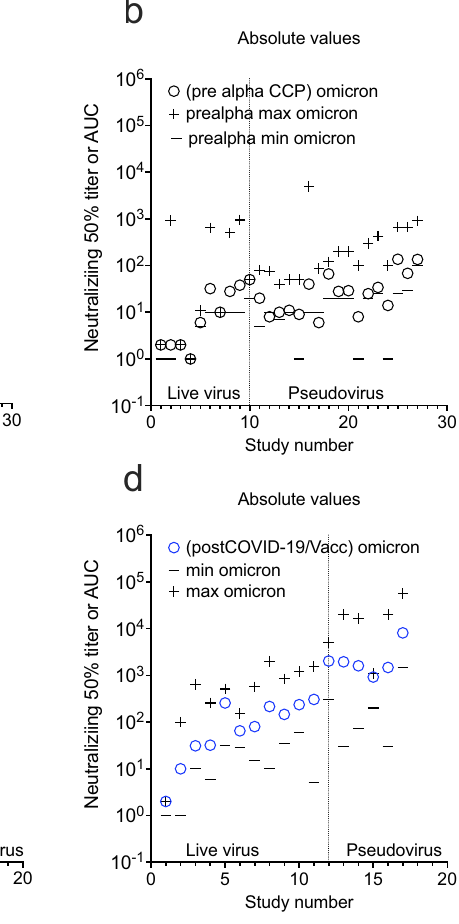
Vax against WA-1. d post COVID-19/Vax against Omicron BA.1. Source data are provided as a Source Data fi